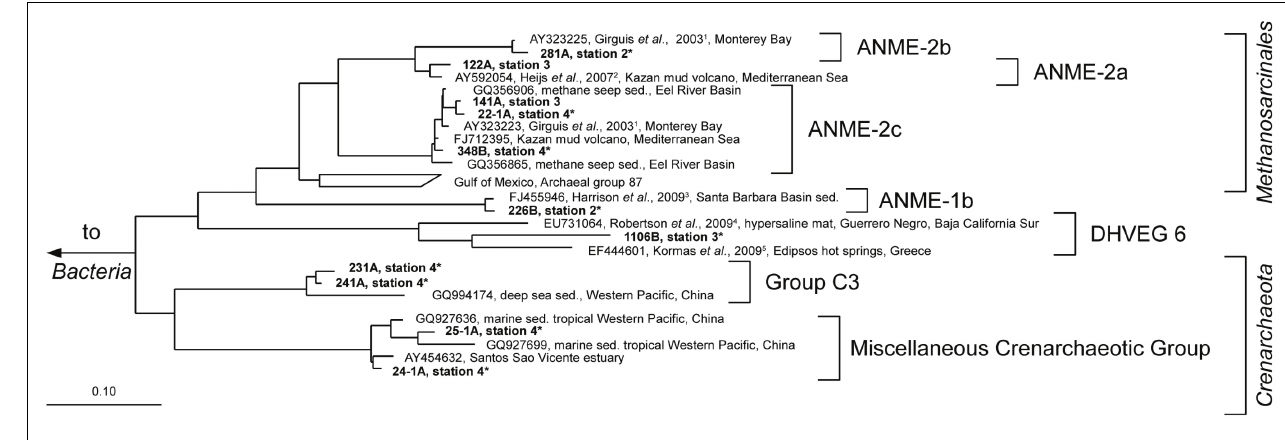
FIGURE 7 | Parsimony tree of archaeal 16S rRNA gene sequences summarizing all sampled stations. Sequences obtained from the Simeulue seep are in bold letters. Numbers describe bands which were excised and used for 16S rRNA gene sequencing from three different DGGE gels with identical patterns. On the right, the deepest branching affiliations are shown. Figure 5 . sed.,